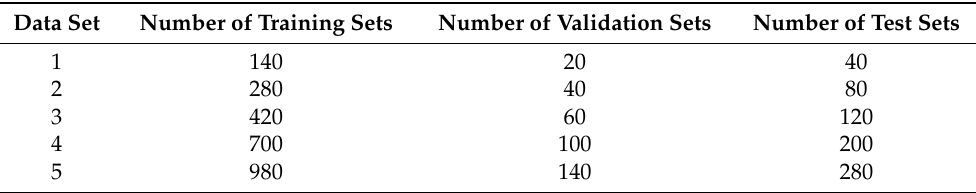
Table 2. Different data set size for each fault.